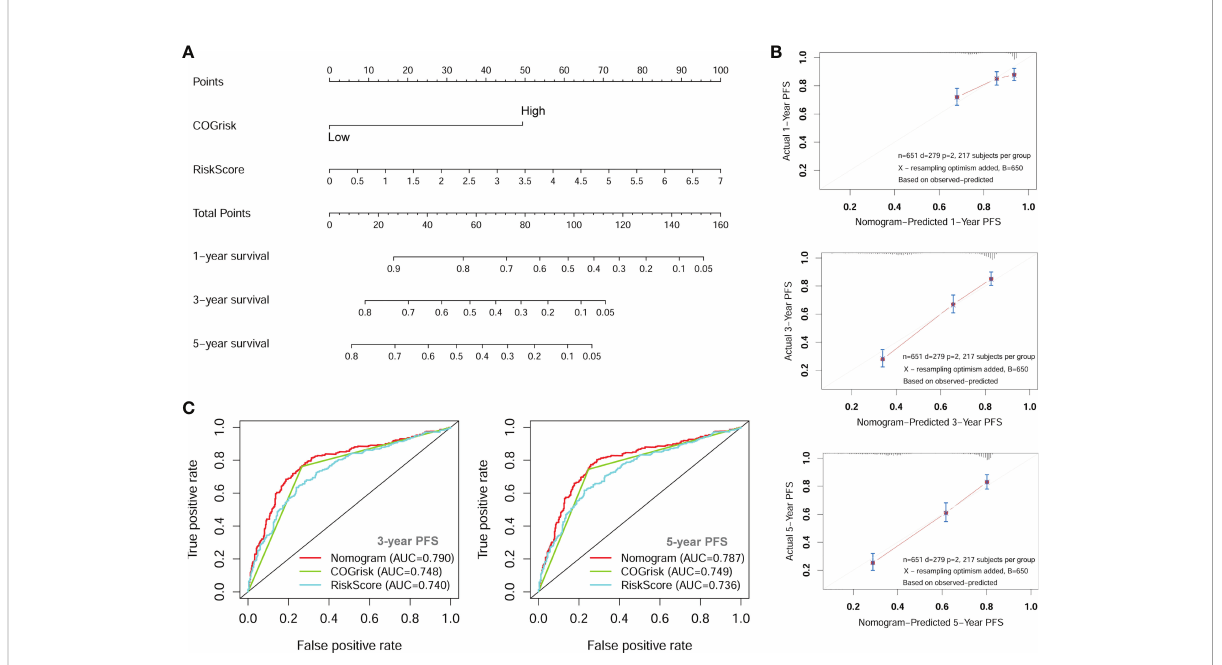
FIGURE 7 The nomogram for predicting of PFS of NB patients. (A) The nomogram incorporating COG risk classi fi cation and four-lncRNA risk score. (B) The calibration curves of the nomogram showing good consistency between predicted-PFS and actual-PFS. (C) The ROC curves showing the AUC of the COG risk classi fi cation and the AUC of the nomogram. lncRNA, long noncoding RNA; PFS, progression-free survival; COG, Children ’ s Oncology Group; ROC, Receiver Operating Characteristic; AUC, Area Under Curve.